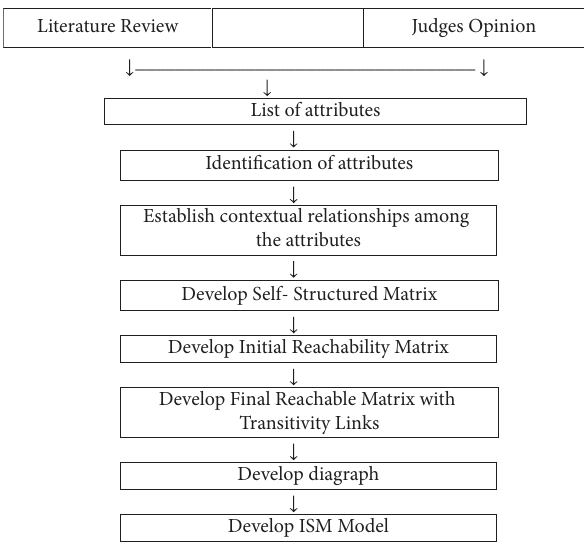
Figure 1: Flowchart of ISM hierarchy. Table 2: Self-structured interaction matrix